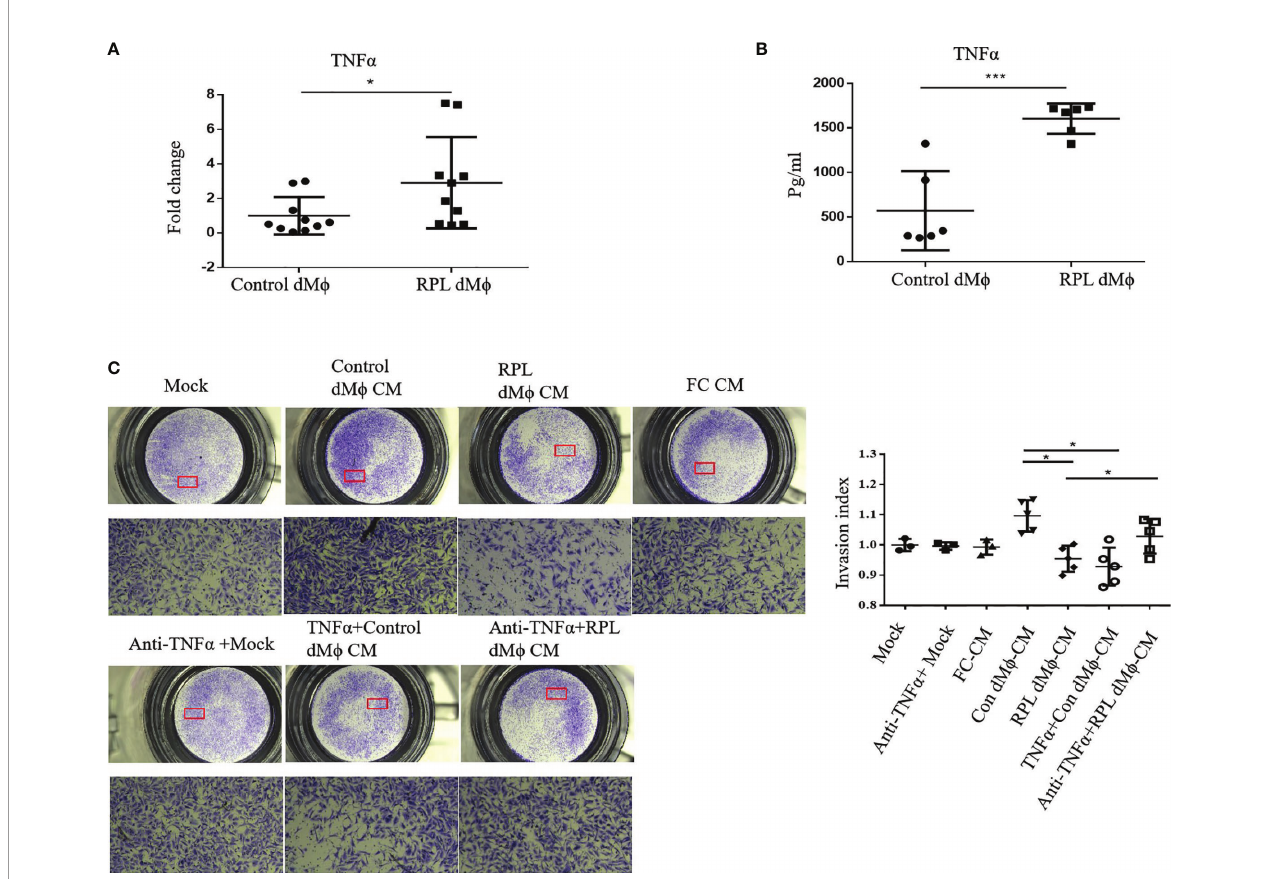
FIGURE 4 | Changes in the expression and secretion levels of TNF a in dM f from RPL patients. (A) TNF a mRNA expression levels in dM f from Control women ( n = 10) and RPL patients ( n = 10) as detected by real-time RT-PCR analysis (normalized to the mRNA expression of Gapdh). (B) Concentration of TNF a in the conditioned media (CM) of cultured primary dM f from Control women ( n = 6) and RPL patients ( n = 6) as detected by ELISA. (C) Invasion of HTR8/SVneo cells as detected by Transwell assay. Left: Representative images of the Transwell assay; Right: quanti fi cations of the Transwell assay by the invasion index [invasion index = X (invaded cells number)/Mock (invaded cells number)]. (Control dM f : dM f from normal women in early pregnancy; RPL dM f : dM f from RPL patients; Mock: treated with medium without cells; FC CM: treated with CM of human fi broblasts; Control dM Ф CM: treated with CM of Control dM Ф ; RPL dM Ф CM: treated with CM of RPL dM Ф ; TNF a + Control dM Ф CM: treated with CM of Control dM Ф plus TNF a ; anti-TNF a +RPL dM Ф CM: treated with CM of RPL dM Ф plus anti-TNF a antibody; * p < 0.05; ***p <